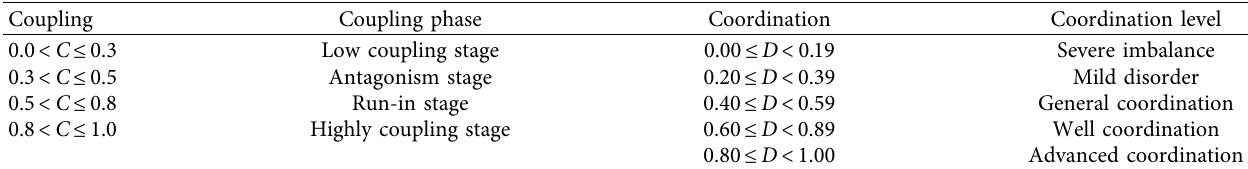
Table 2: The classification of coupling degree and coordination